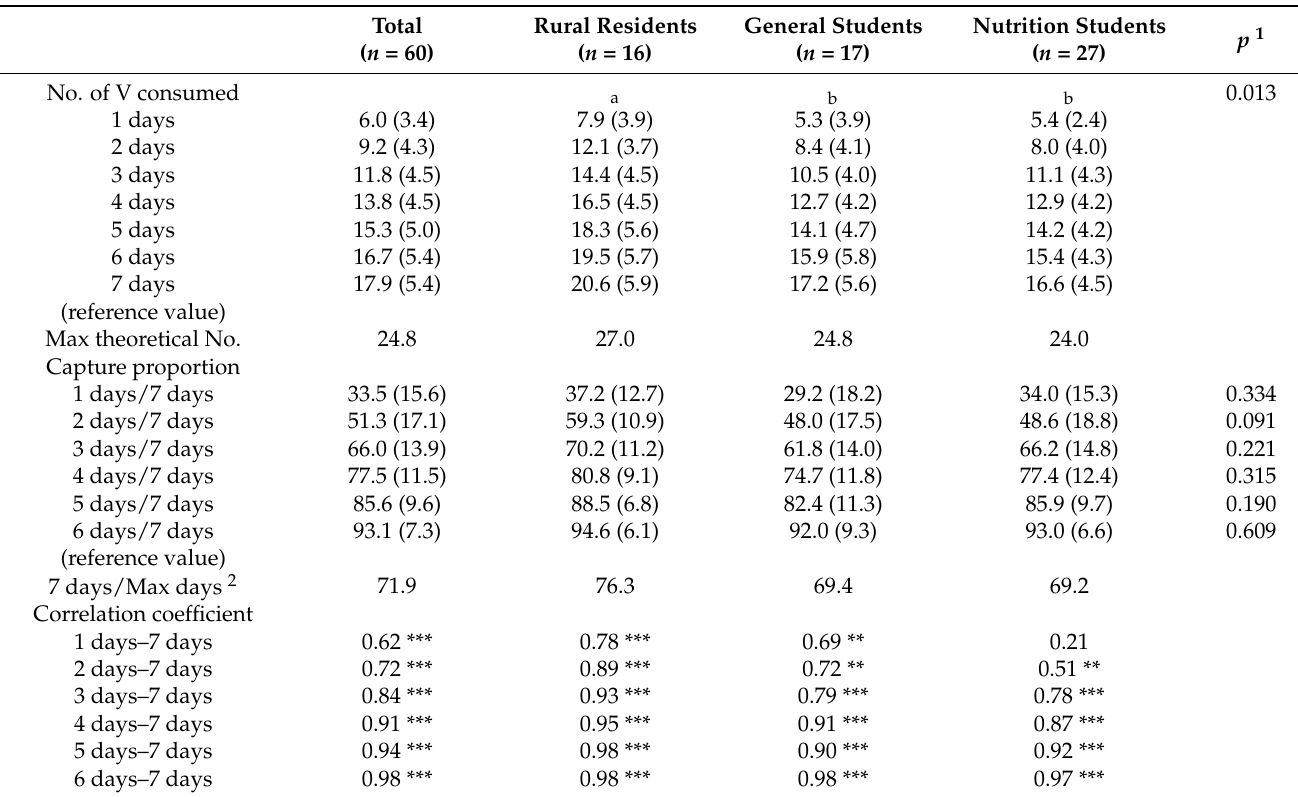
Table 3. Vegetable variety of the participants ( n =